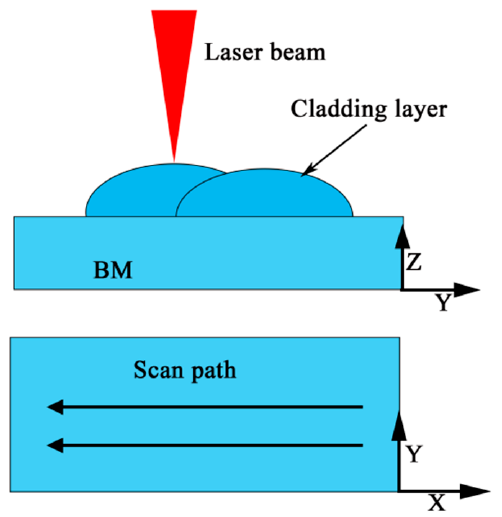
Figure 3. Diagram of the underwater laser cladding.